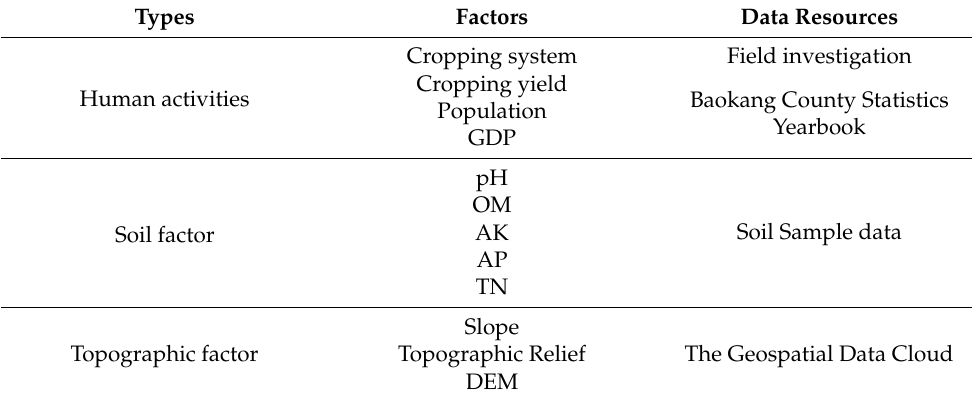
Table 4. All influenced factors selected by us as the